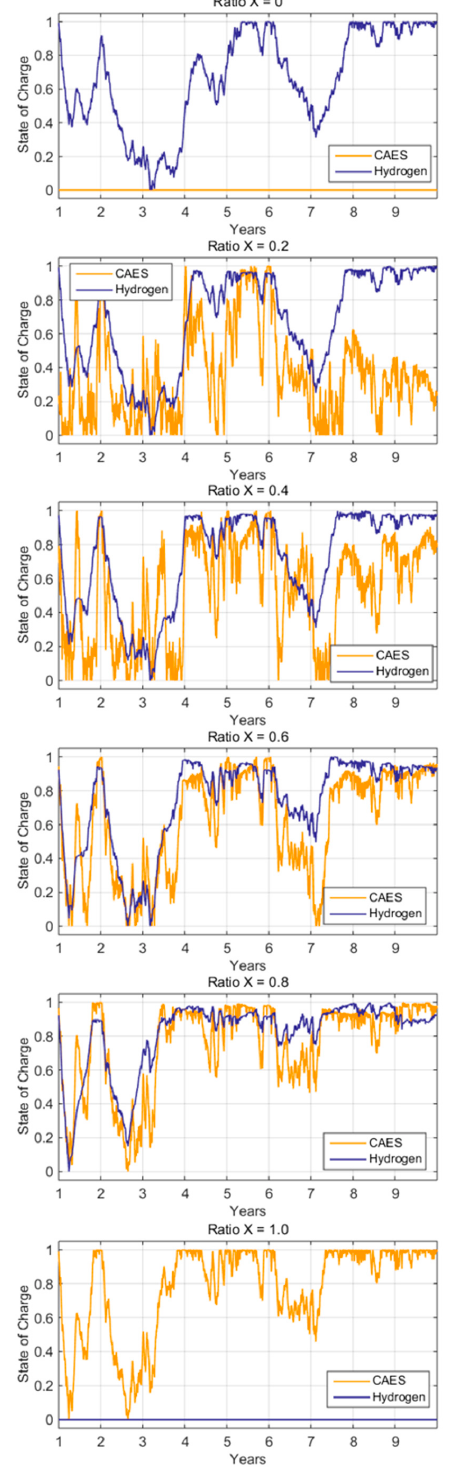
Figure 12. Comparison of the state of charge of both energy stores for different ratios X.